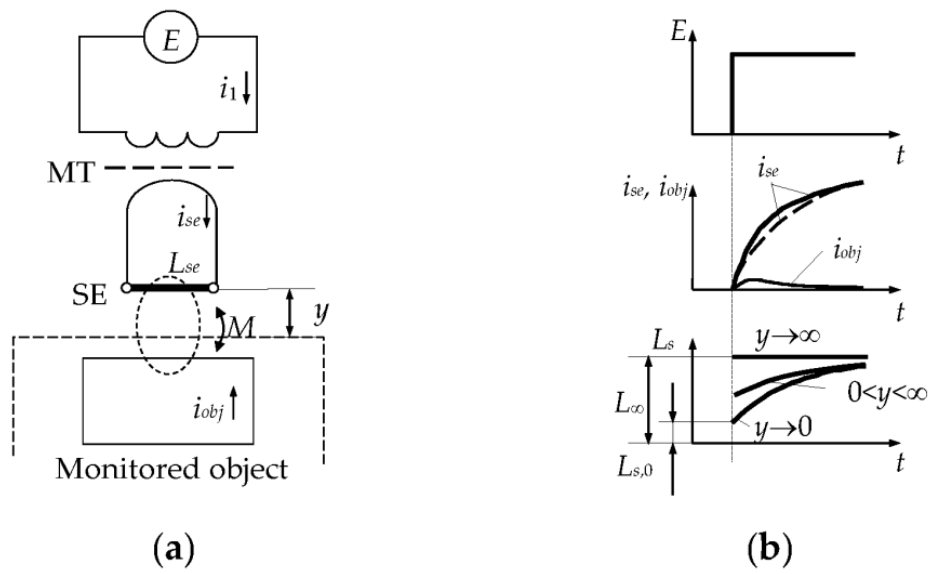
Figure 2. Double contour model of the electromagnetic interaction between the SE of the SCECS and the electrically conductive object ( a ), and the time diagrams of changes in the currents and equivalent inductance of the SE ( b ) [18,36].